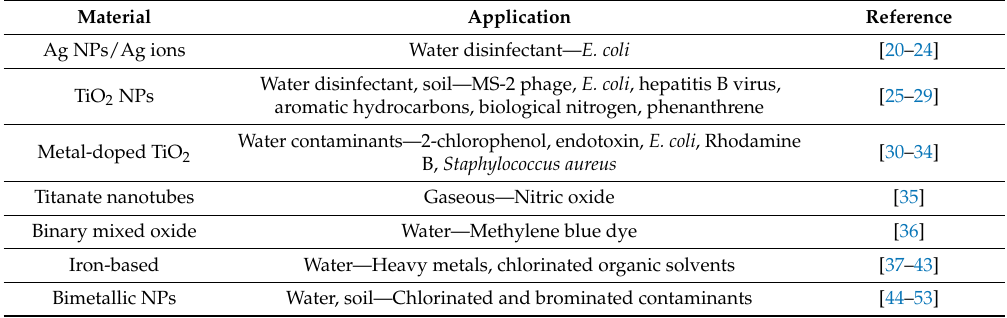
Table 1. Metal-based nanomaterials and applications in environmental remediation of contaminants.